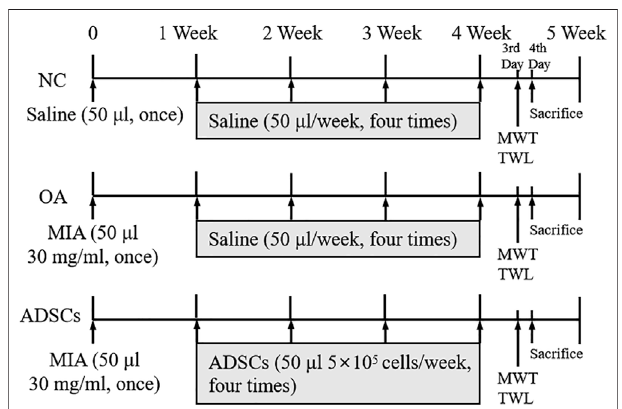
FIGURE 1 | Timetable for the experimental design. OA model was generated with the intra-articularly injection of monoiodoacetate (MIA) in rats (7 weeksold)onceandleftforrecoveryfor1 week,followedbyintra-articularly injection of saline or ADSCs for four consecutive weeks at the fi rst day of the second, third, fourth and fi fth week. NC, normal control group; OA, OA model group;ADSCs,ADSCstreatedmodelgroup.Atthethirddayofthe fi fth week,themechanicalwithdrawalthreshold(MWT)andthethermalwithdrawal latency (TWL) were measured replicatedly for three times, respectively. At the fourth day of the fi fth week, all rats were sacri fi ced for histopathological and immunohistochemical analyses, qRT-PCR and western blot analysis.